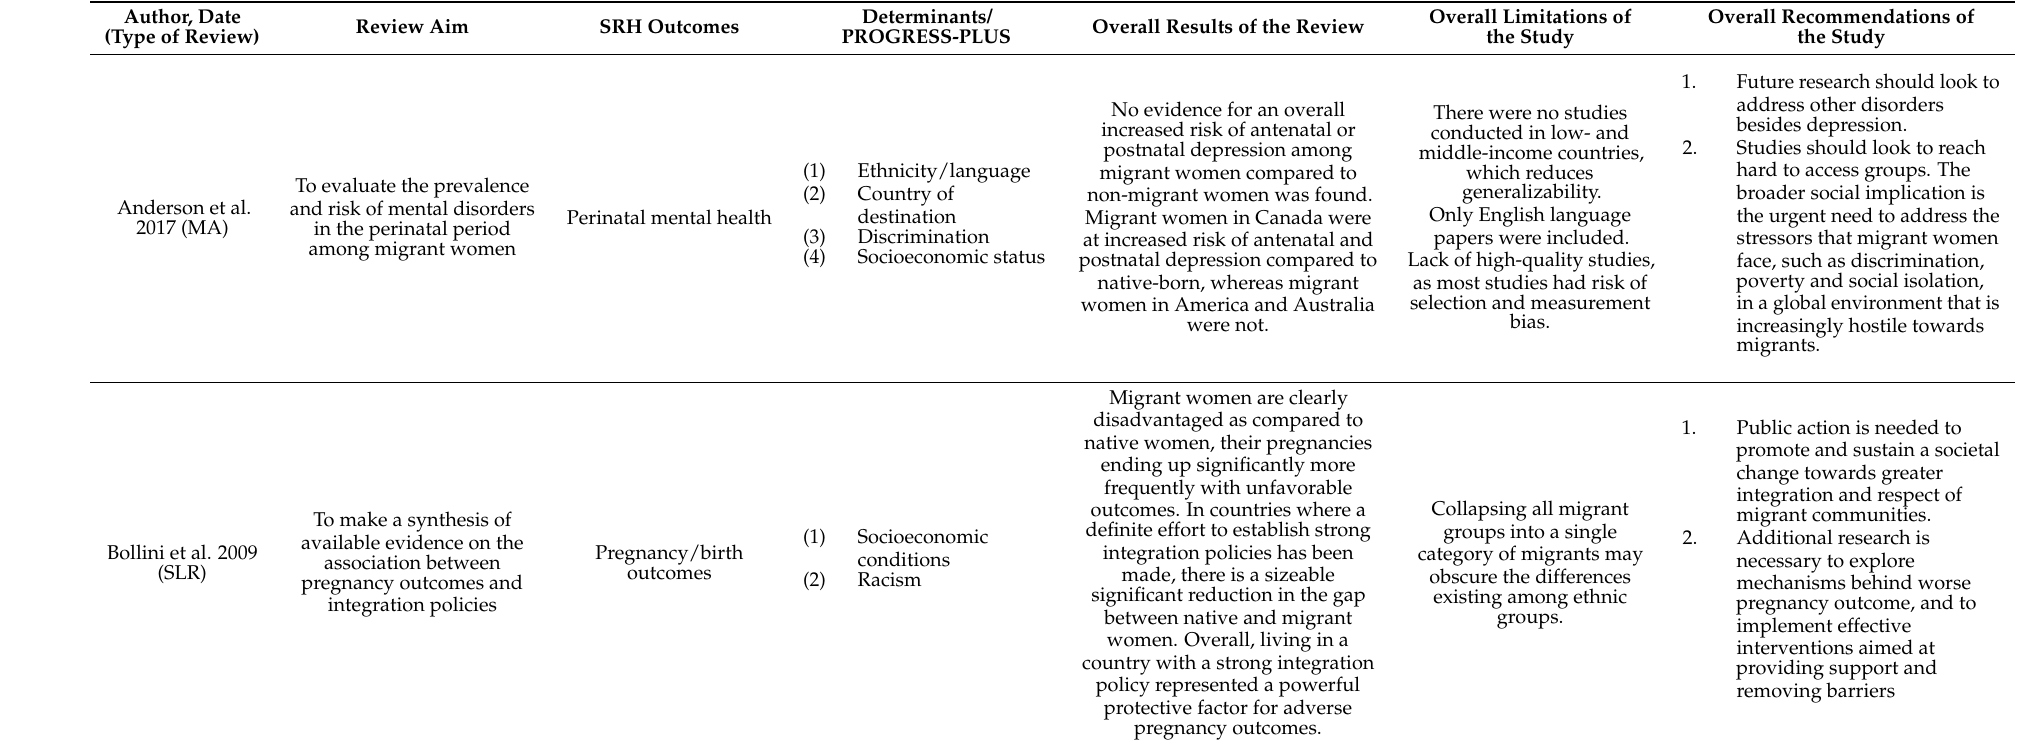
Table 3. Systematic literature reviews and meta-analyses goals and